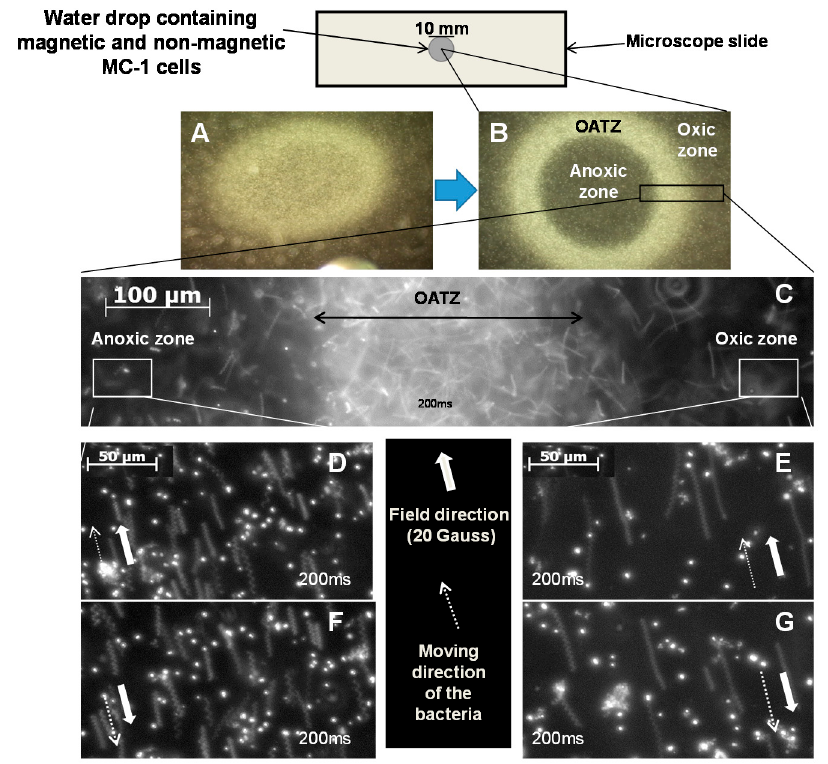
Figure 4. Motion behaviors of MC-1 bacteria. ( A ): Optical microscopy image of a mixture of magnetic MC-1 cells and non-magnetic mutants of the MC-1 cells immediately after mixing in a drop of water; ( B ): A ring of densely populated bacteria at the OATZ at ~0.5% O 2 was initially formed in the presence of the geomagnetic field. The image shows MC-1 bacteria leaving the OATZ after a magnetic field of 20 Gauss is directed towards the anoxic and the oxic zones while the non-magnetic mutants remain in the OATZ; ( C ) Close-up of the section of (B) depicting a dense population of MC-1 cells in the OATZ with some magnetic bacteria already in the anoxic and the oxic zones immediately following the application of the directional magnetic field, successively directed towards the anoxic and the oxic zones; ( D , F ): Close-ups of a section of the anoxic zone depicting the magnetic MC-1 bacteria swimming in a new direction after the application of a 20 Gauss magnetic field; 200 ms exposure; ( E , G ): Close-ups of a section of the oxic zone depicting the magnetic MC-1 bacteria swimming in a new direction after application of a 20 Gauss magnetic field at lower velocities than the ones in the oxic zone, suggesting that MC-1 velocity decreases as the oxygen level decreases for the same directional magnetic field